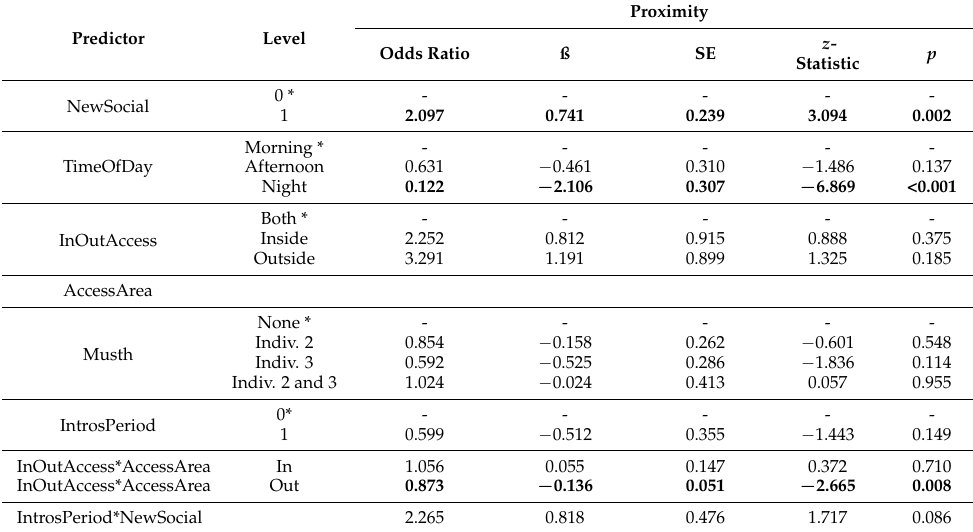
Table A12. New social GLMER model parameter estimates for proximity response variable. Gener- alized linear mixed-effect model results of associations between predictor variables (fixed effects) and proximity response variable for all focal animals. ß = Beta coefficients from model outputs: positive values indicate an increase in odds compared to the reference level while negative values indicate a decrease in odds compared to reference level; SE = standard error of beta coefficients; Wald X 2 = Chi-squared statistic from Wald test with df = 1; p = p -value from Wald test. * indicates reference level. Bold signifies statistical significance ( p <